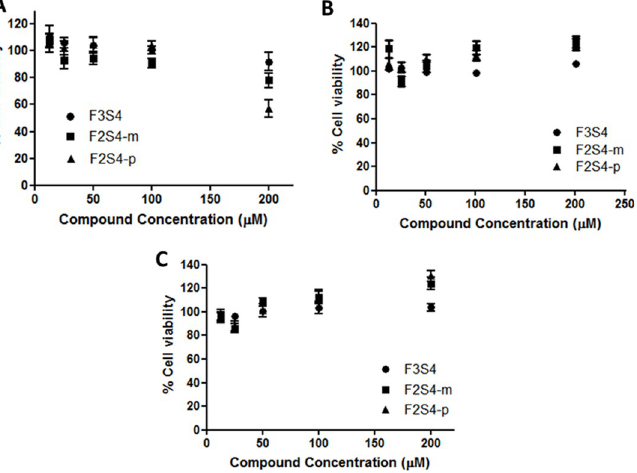
Fig 8. Cytotoxic evaluation of compounds F3S4-m , F2S4-m , F2S4-p in different cell lines by MTT assay: A) Fibroblasts, B) Primary culture of astrocytes and C) PC12 cells.